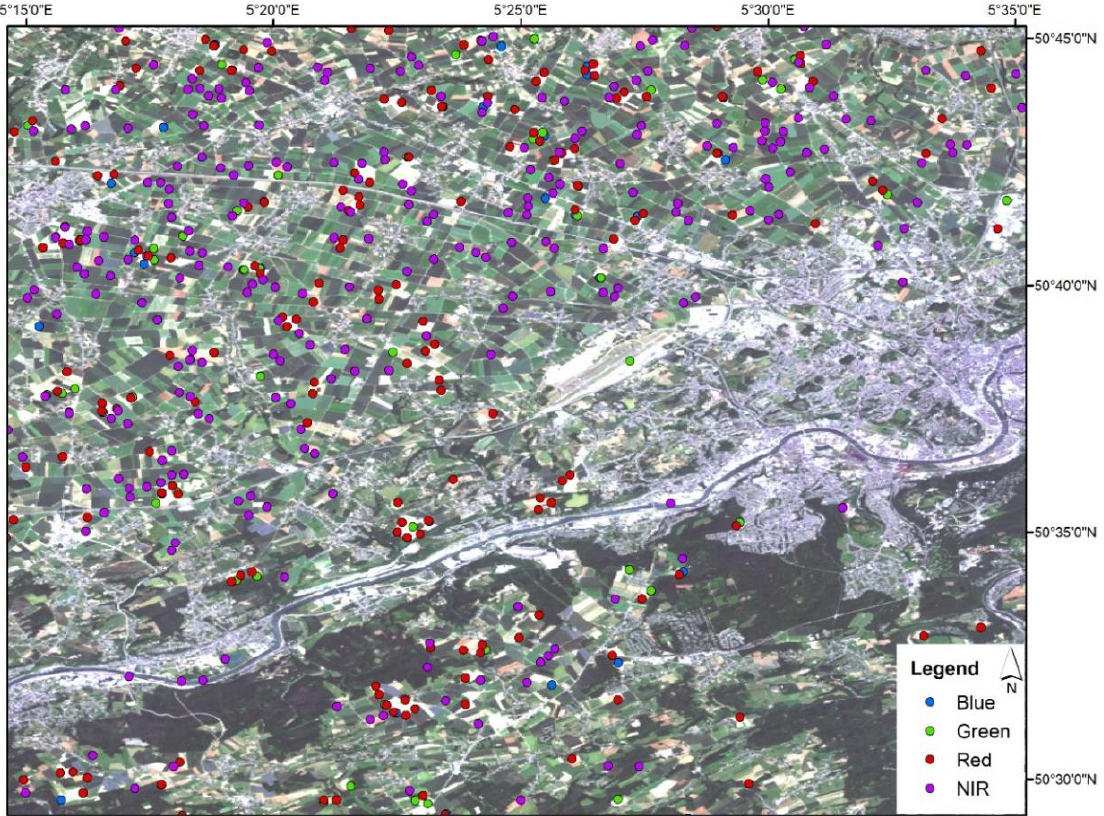
Figure 8. Example of eligible edges detected by SaSbEM in a portion of the Subset ID #1 image. The edges are represented as point features, and they are differentiated according to the wavelength of the band in which they were mapped (see legend). The reference system of the image is WGS 84 (EPSG: 4326).